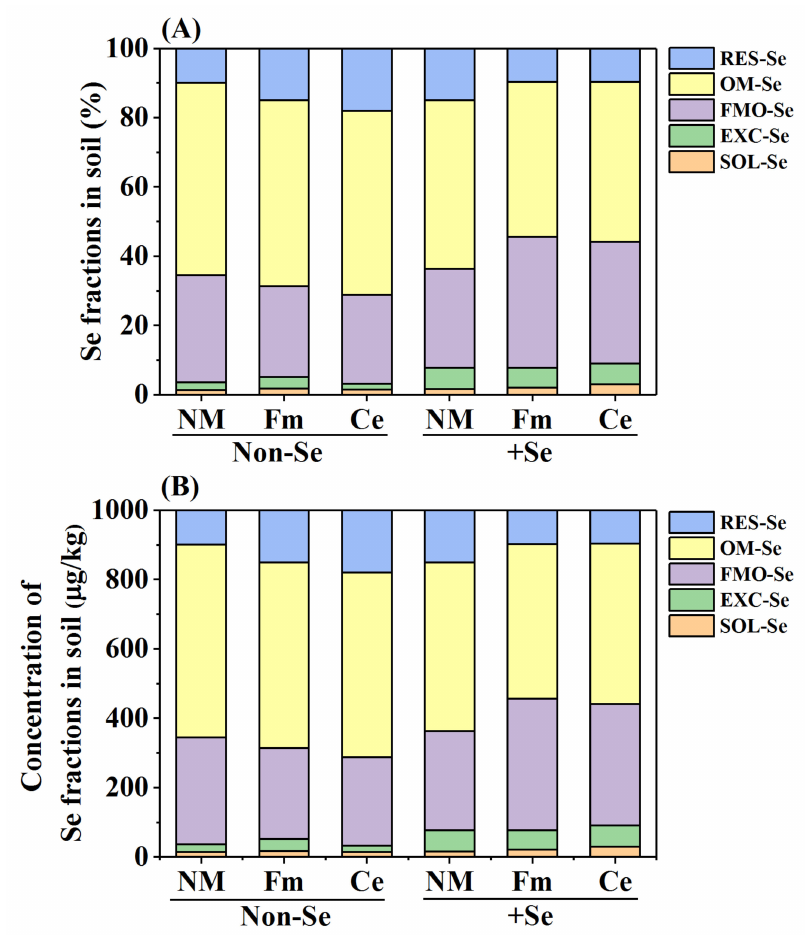
Figure 1. Effects of AMF inoculation and Se fertilization on distribution of Se fractions ( A ) and the concentration of Se fraction ( B ) in the soil. Here, SOL-Se indicates water-soluble Se, EXC-Se indicates exchangeable and carbonate-bound Se; FMO-Se indicates Fe/Mn oxide-bound Se; OM-Se indicates organic matter-bound Se; and REC-Se indicates residual Se. NM indicates the treatment without AMF, Ce indicates Claroideoglomus etunicatum ; Fm indicates Funneliformis mosseae